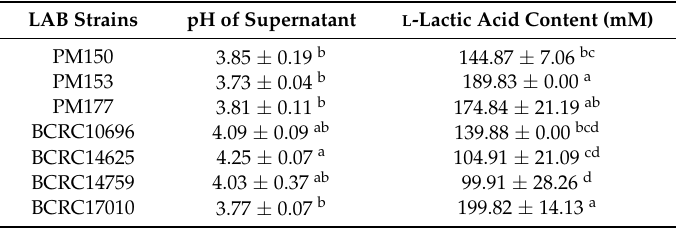
Table 1. The pH values and L -lactic acid contents of Lactobacillus supernatants.